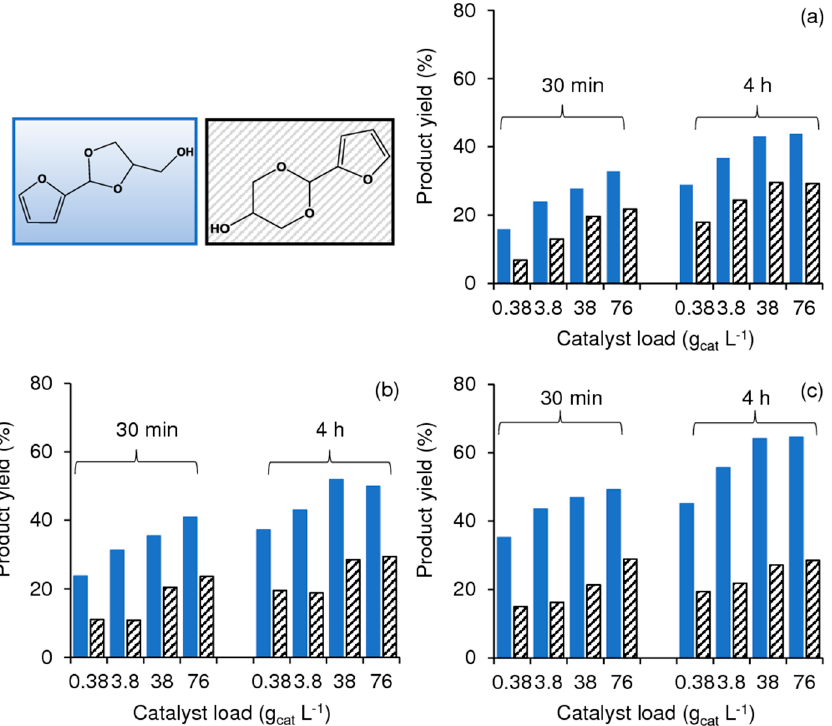
Figure 5. Influence of the catalyst load, reaction temperature and time on the dioxolane (blue bars) and dioxane (striped bars) yields for the Fur/Gly reaction in the presence of 1 , at ( a ) 50 °C, ( b ) 70 °C and ( c ) 90 °C.